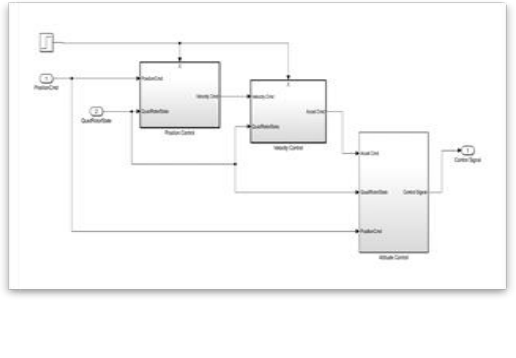
Figure 7. Position control design strategy